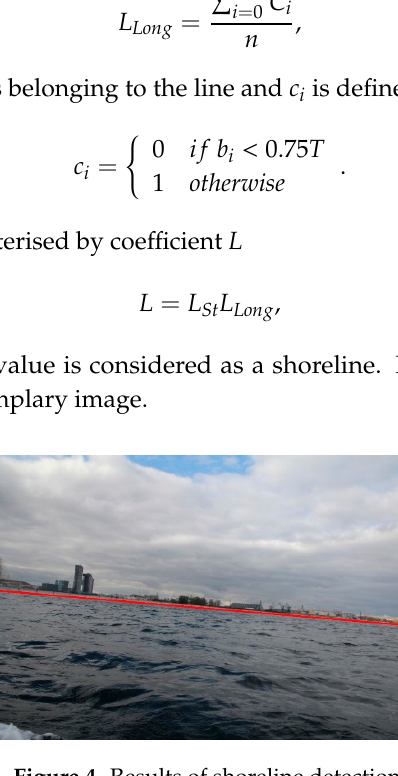
Figure 4. Results of shoreline detection.